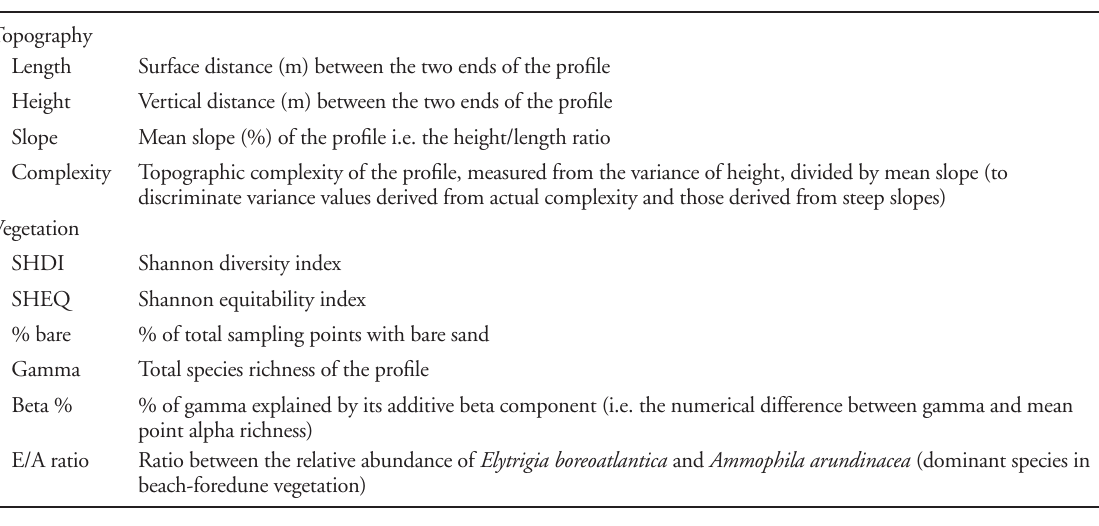
Table 1. Quantitative attributes calculated for each vegetated profile from the topographic and vegetation datasets.